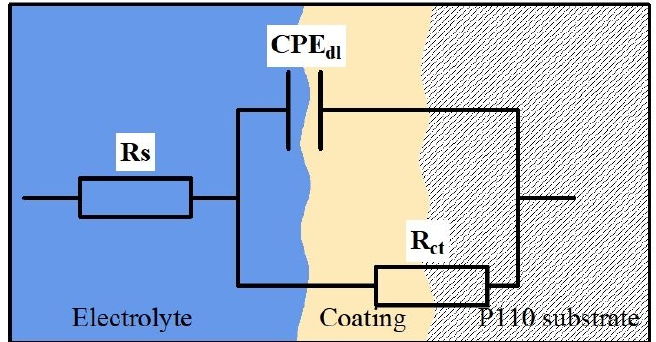
Figure 6. EIS of Ni-W-CF composite coatings with different concentrations of CF.